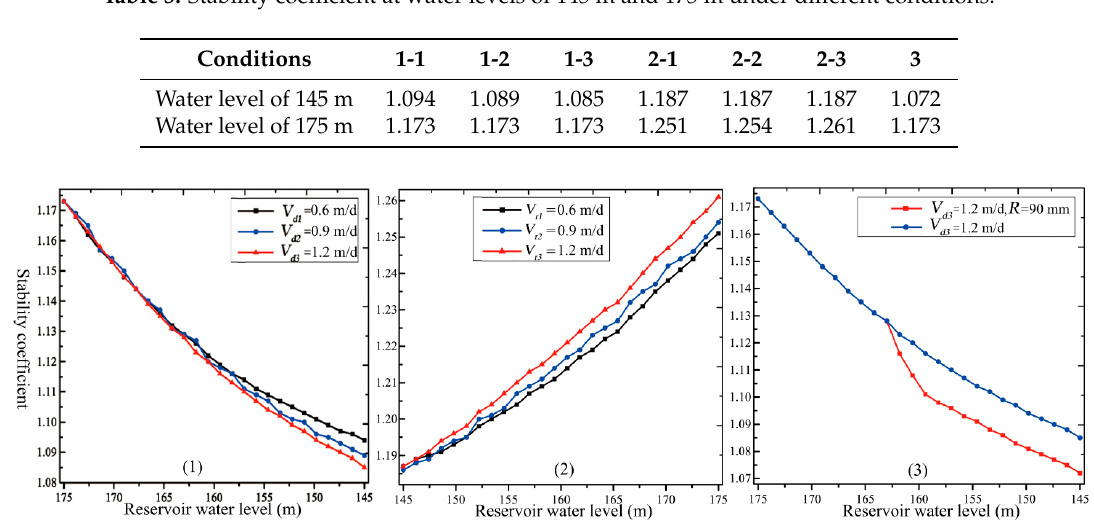
Figure 9. Stability coefficient of the Sifangbei landslide under different operating conditions.